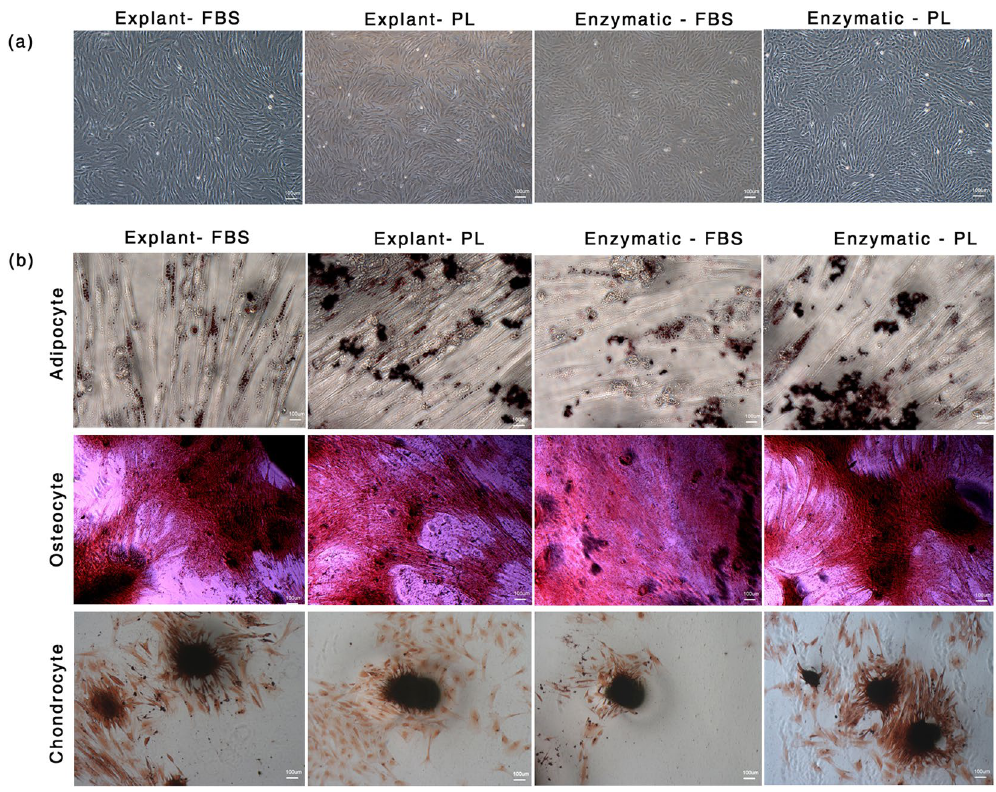
Figure 3. MSC characteristics as per ISCT criteria. ( a ) Plastic adherent MSC with fibroblast like shape. ( b ) Tri- lineage differentiation potential as shown by oil red O, alizarin red S and safranin O respectively for adipocytes, osteocytes and